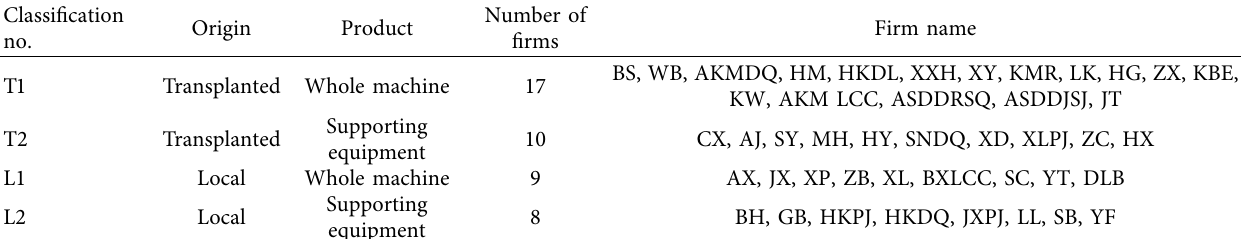
Table 1: General situation of the firms in the refrigeration industrial cluster of Minquan county. Classification